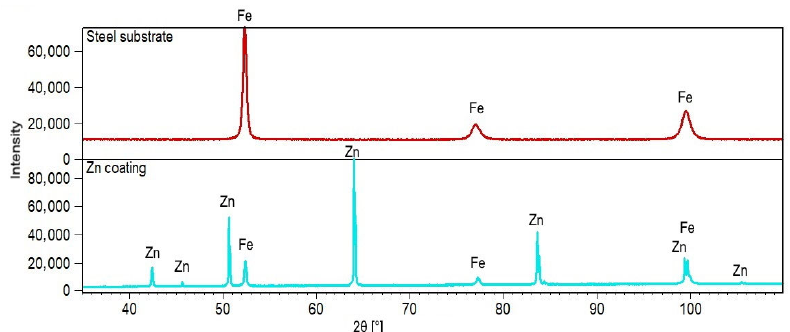
Figure 2. XRD pattern of the substrate martensitic steel and steel with the applied Zn coating.